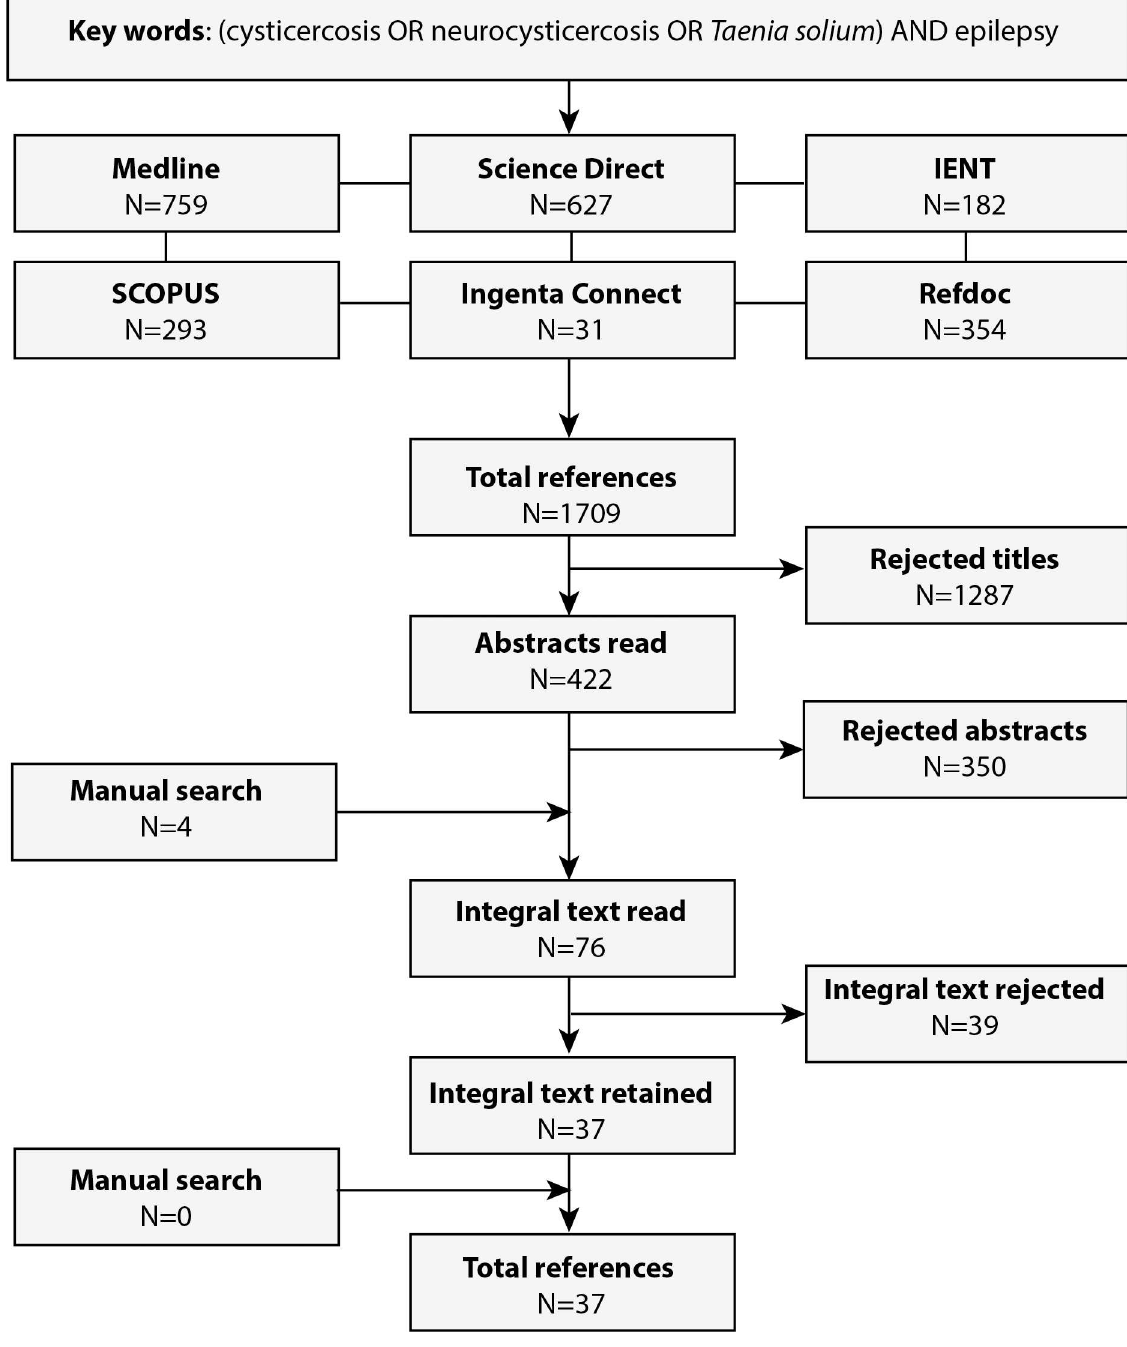
Fig 1. Flowchart of literature